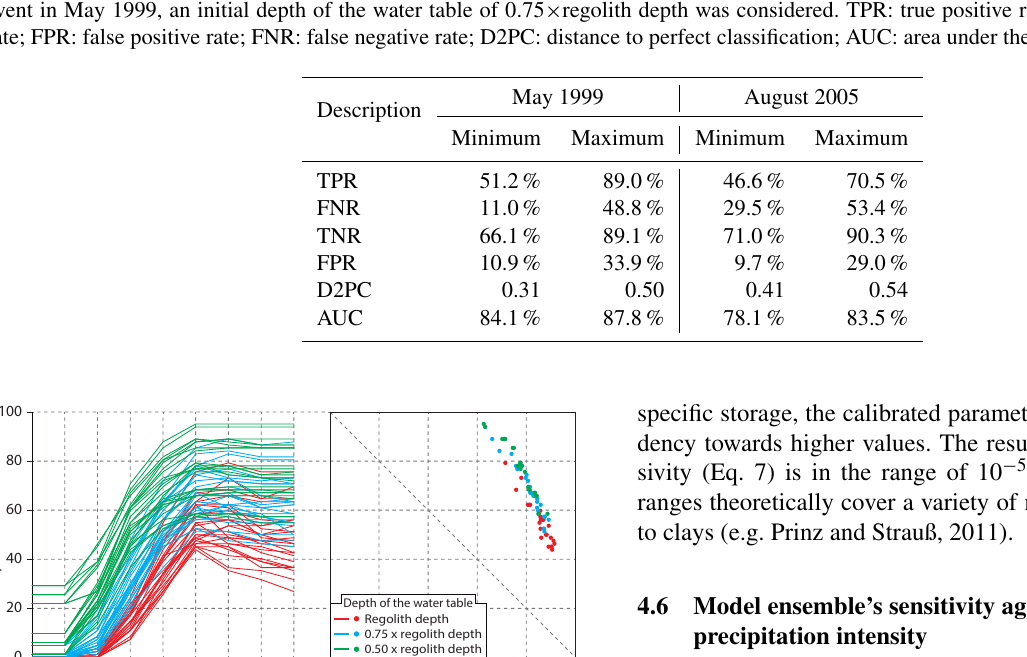
Table 8. Prediction rates of the model ensemble for the landslide-triggering rainfall events in May 1999 and August 2005. For the rainfall event in May 1999, an initial depth of the water table of 0 . 75 × regolith depth was considered. TPR: true positive rate; TNR: true negative